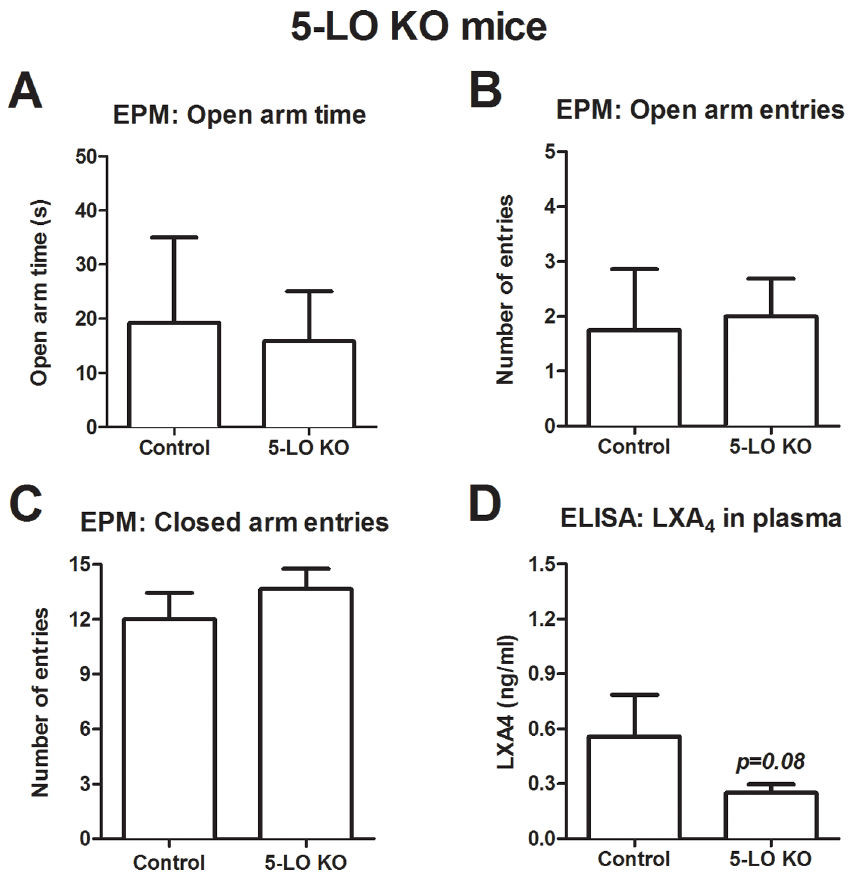
Figure 2. 5-LO knockout mice exhibit unaltered anxiety-like behavior in the EPM test. No difference was observed between control and 5- LO knockout mice as to (A) open arm time, (B) open arm entries or (C) closed arm entries (n=8 2 12). (D) 5-LO knockout mice show significantly reduced lipoxin A 4 in plasma (n=8 2 10). Data are expressed as mean 6 SEM and statistical analysis was performed by two-tailed or one-tailed Student’s t test, respectively. KO: knockout, 5-LO: 5-lipoxygenase enzyme.